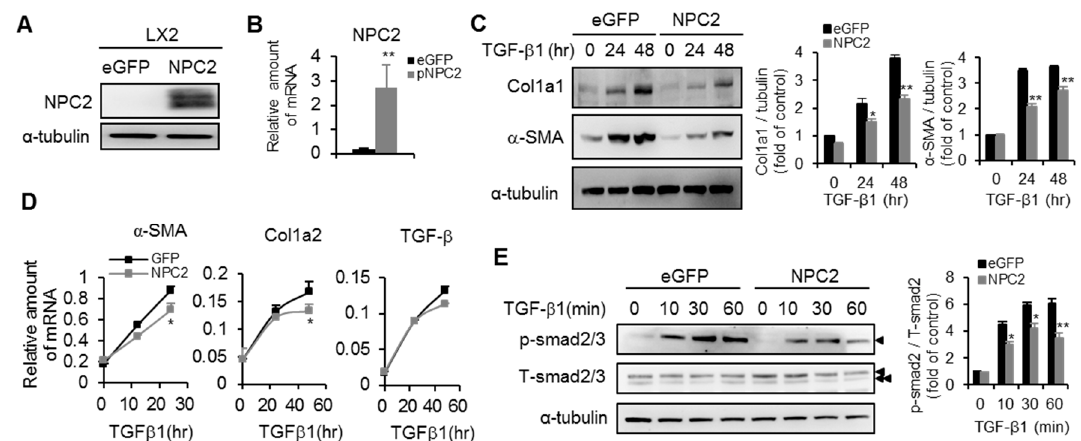
Figure 5. Overexpression of NPC2 attenuates TGF- β 1-induced fibrogenesis in LX2 cells. LX2 cells were infected by lentiviruses carrying the eGFP control and NPC2 gene. After puromycin-based selection for 1 week, the cells were harvested and confirmed by ( A ) Western blotting and ( B ) Q-PCR; ( C ) Different lentiviruses infected LX2 stable cells were treated with 20 ng/mL TGF- β 1for the indicated time periods, and the lysates were immunoblotted and then quentified to detect α -SMA and Col1a1; ( D ) Results from Q-PCR analyses of α -SMA, Col1a2 and TGF- β expression in LX2 stable cells treated with 20 ng/mL TGF- β 1. * p < 0.05; ** p < 0.01 vs. eGFP control; ( E ) Different LX2 stable cells were treated with 20 ng/mL TGF- β 1 for the indicated time periods, and the lysates were immunoblotted and then quentified to detect Smad2 phosphorylation ( ► , smad2, ►► , smad3). Each experiment was performed in three independent replicates. A similar phenomenon was observed. Therefore, the representative data was shown in the figure.